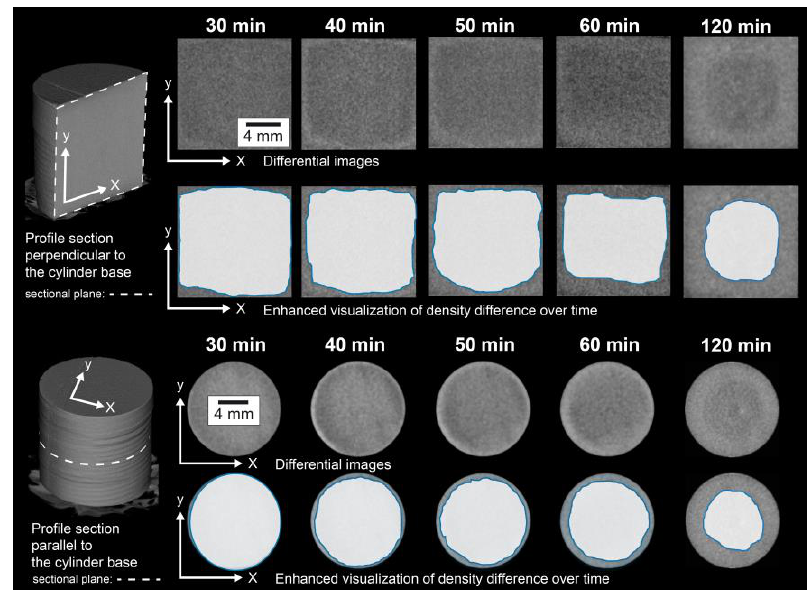
Figure 3. Results of the in situ micro-CT examinations in cross-sections perpendicular and parallel to the base of the core over time (for 2 h at 100 °C).